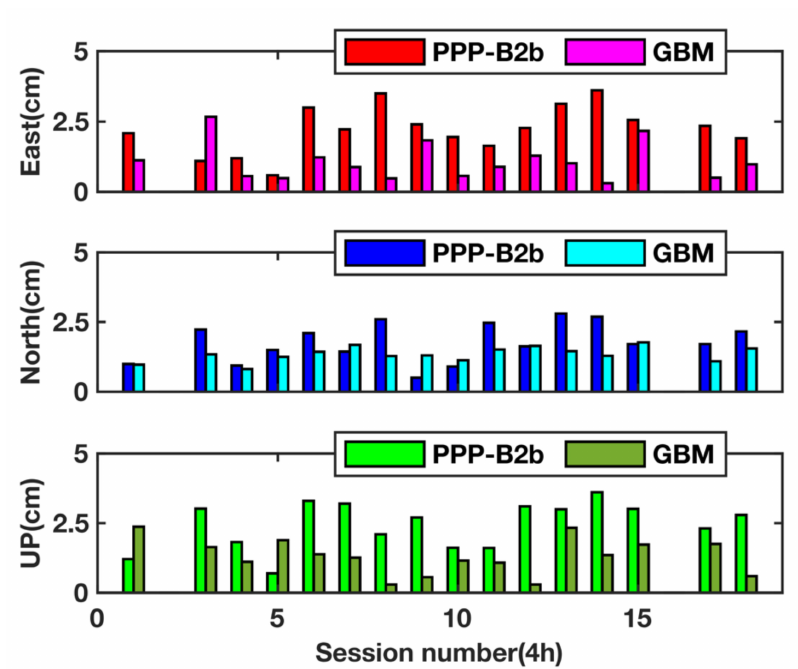
Figure 9. Positioning accuracy of static PPP with different data sessions at BJF1 station.